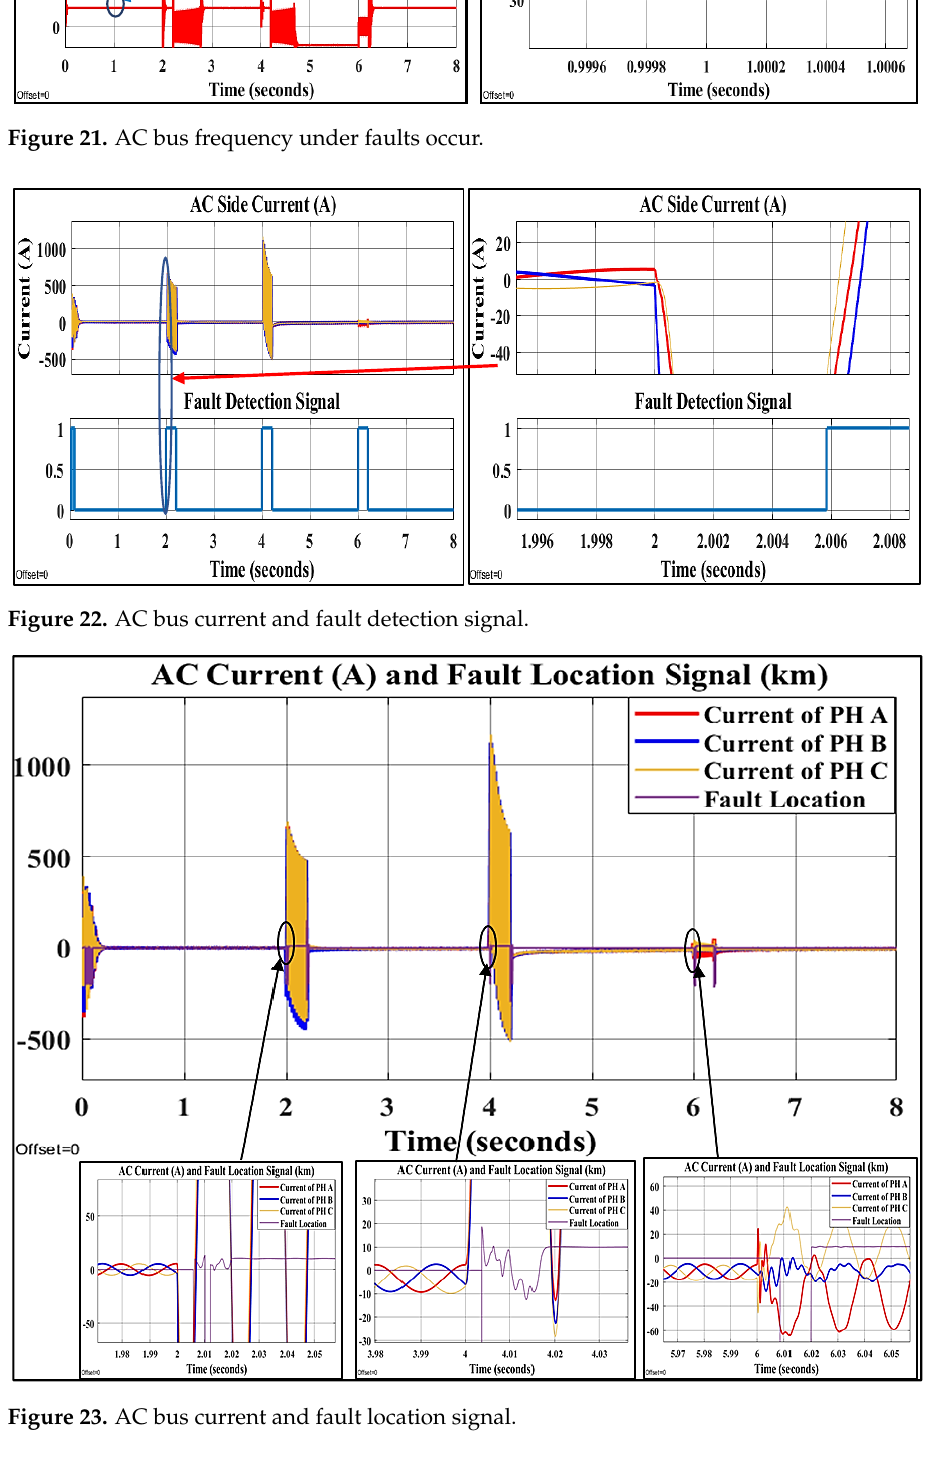
Figure 23. AC bus current and fault location signal . As shown in Figure 24a,b, the best validation performance for fault classification and detection is 1.2787 at epoch 73 while it is 4.1622 × 10 −10 at epoch 664 for fault location. The MSE is the square root of the average difference between outputs and targets. Reduced values are preferable while zero indicates no error [67]. Figure 24 depicts the variation in validation, training, and test errors as a function of the number of training epochs. The graph shows the network ’ s MSE beginning at a large value and gradually decreasing to a smaller value, indicating that the network learned properly. As the weights improve, the error in the training set decreases. After 73 and 664 epochs, respectively, training was halted when the validation error began to increase. This result is reasonable because the final MSE is small, the error characteristics of the test and validation sets are similar, and no significant overfitting occurred at 73 and 664 epochs, respectively. ( a ) ( b ) Figure 24. The evolution of training, validation, and test errors for ( a ) fault classification and detec- tion and ( b ) fault location.